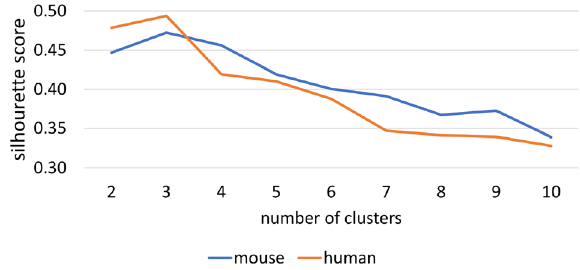
Figure 5. Silhouette score for the human ( k h ) and mouse ( k m ) organisms.